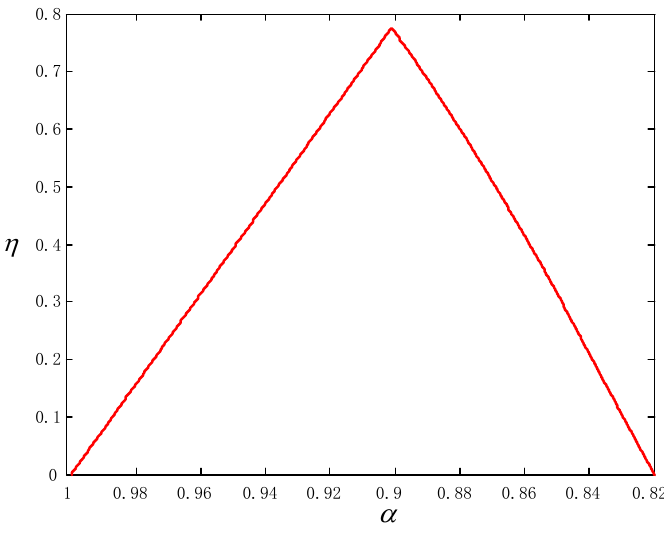
Figure 9. The maximum overall satisfactory degree.